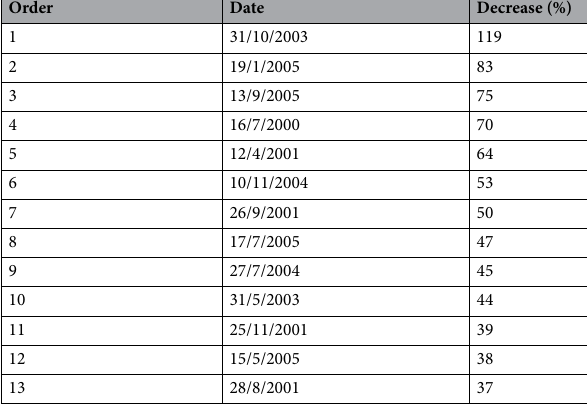
responses with the cloud distributions of liquid clouds, high clouds, and ice clouds of Fig. 6 provide valuable information on the workings of the ion-cloud link. From Fig. 4 (top right panel) one see the response in NET radiation and comparing the maximum responses with the distribution of liquid clouds Fig. 6 (top panel) the NET responses are mainly over the clean southern oceans and where low clouds dominate. Furthermore, com- paring Fig. 6 (middle right panel) with Fig. 4 LW (bottom right panels) it is seen that large responses in LW are mainly confined to regions with a high frequency of deep convective clouds. The same LW regions can be seen in the SW map in Fig. 4 (middle panels) with a near cancellation of LW and SW signals, in agreement with the well-known effect of deep convective clouds having significant but compensating effects in the LW and SW that largely cancel 29 . These observations therefore imply that the main NET effect of FDs on the radiative budget is from low liquid clouds caused by the change in the cloud fraction with SW albedo changes dominating. Although FD 2 is the strongest, by excluding it from the map in Fig. 4 we demonstrate that the remaining four strongest FD still produced quite a similar pattern of responses, as can be seen from Fig. 5. A further complication to FD 2 is that one of the strongest ground level events occurred within the FD decrease, which has the opposite effect of the FD by increasing the ionization. The acceleration of particles in a ground-level event is due to solar activity. The particle energy is rarely more than 10 GeV (much lower than Galactic cosmic rays) and with a peak lasting less than an hour. The solar accelerated particles are therefore usually too weak to penetrate Earth’s magnetic field at low latitudes. Neutron monitor counts of daily-mean show that the ground level event does not dominate the FD2 event for latitudes below approximately 55 deg., corresponding to more than 80% of Earth. However, the ground-level event dominates in the polar regions, with a significant excess of atmospheric ionization. From the cosmic ray, aerosol, and cloud link, one would expect a decrease in cosmic rays, aerosol, and cloud over most of Earth, except in polar regions, where the increased ionization should produce an excess of aerosols. Such an increase has been seen 31 . Consequently, this unique feature of FD2 provides an additional independent consistency test of the cosmic-ray-aerosol link. In summary, the results presented show that